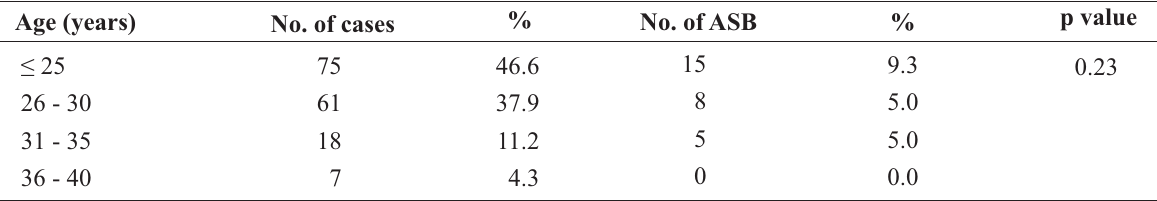
Table 1: Distribution of cases according to age Age (years)